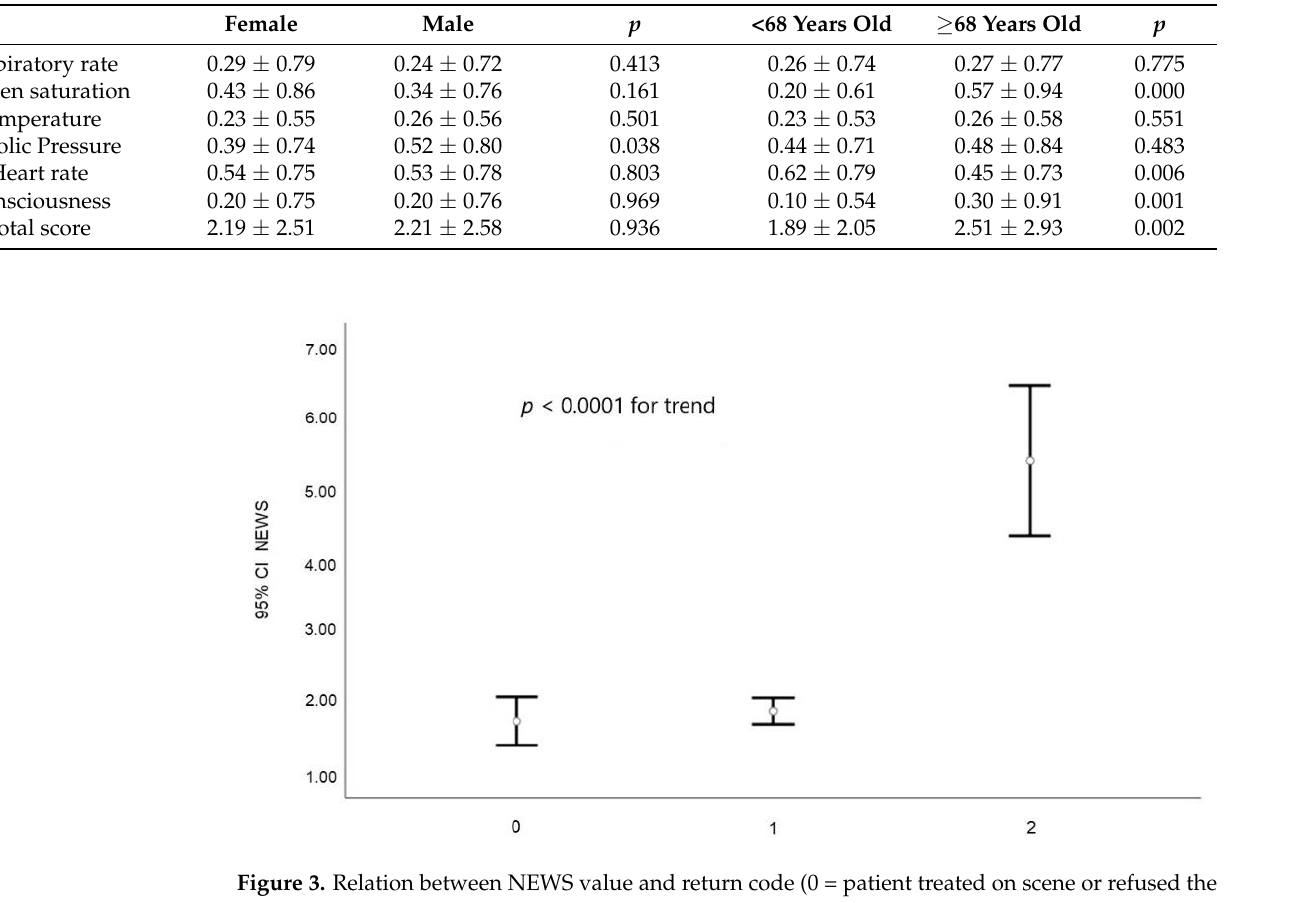
Figure 3. Relation between NEWS value and return code (0 = patient treated on scene or refused the transport, 1 = low severity, 2 = high severity).